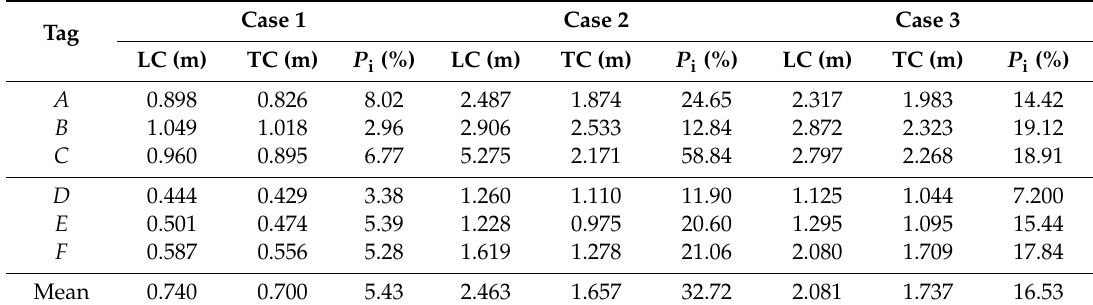
Table 5. Comparison of RMSEs in the float solution between LC and TC under di ff erent scenarios and the corresponding